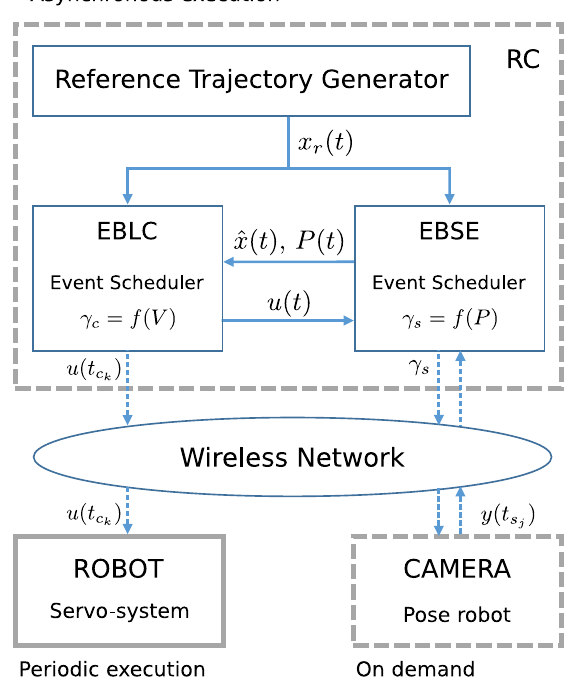
Figure 2. Description of the tasks carried out by the remote centre: reference trajectory generation, event-based state estimation with measurement request triggering and event-triggered control based on Lyapunov functions for asynchronous actuations on the